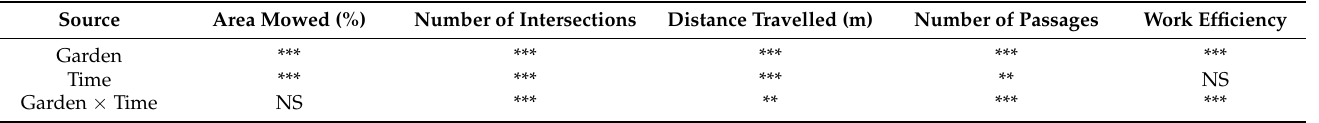
Table 1. Results of ANOVA testing the effects of garden typology (Garden), time intervals (Time), and their interaction on the percentage of area mowed (Area mowed), the number of intersections (Intersections), the distance travelled (Distance), the number of passages (Passages), and the working efficiency (Efficiency).